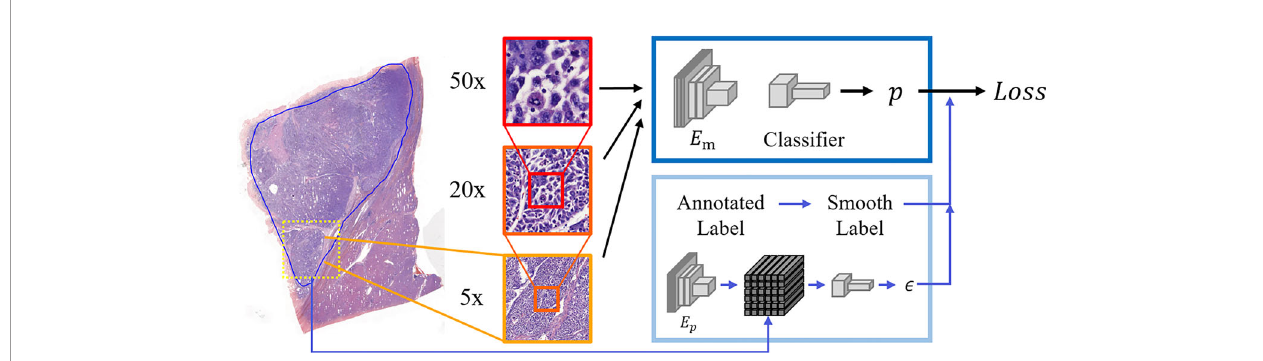
FIGURE 4 | One of the whole-slide images of hepatocellular carcinoma tissues. The width of the image is around 10k pixels. In the fi gure to the left, the blue line drawn by pathologists points out the tumor regions roughly, containing non-tumor areas without tumor features. In the fi gure to the right, with elaborate annotation, in addition to the blue line showing the cancer region precisely, the yellow line circles the non-tumor parts within the tumor.